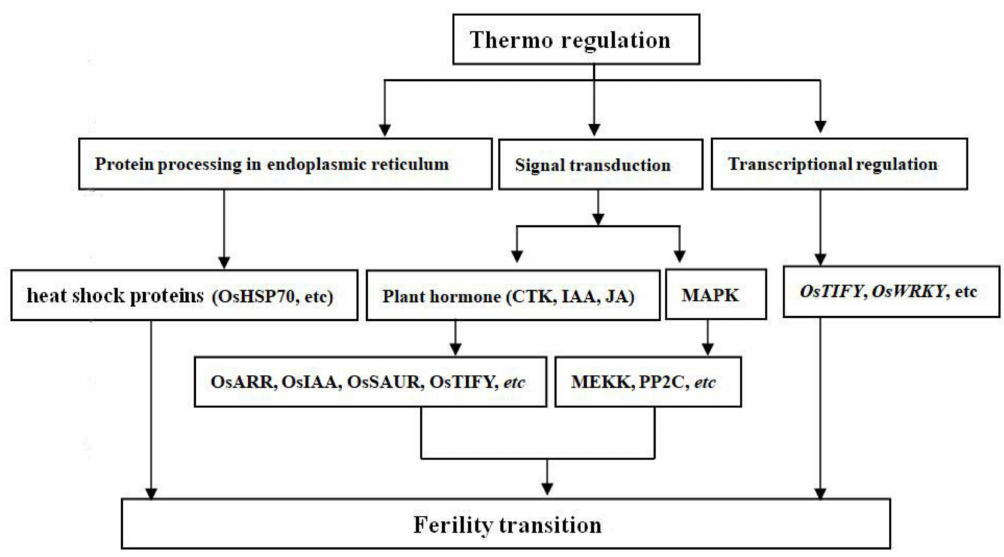
Figure 7. The proposed model of fertility transition mechanism in the TGMS rice line Zhu